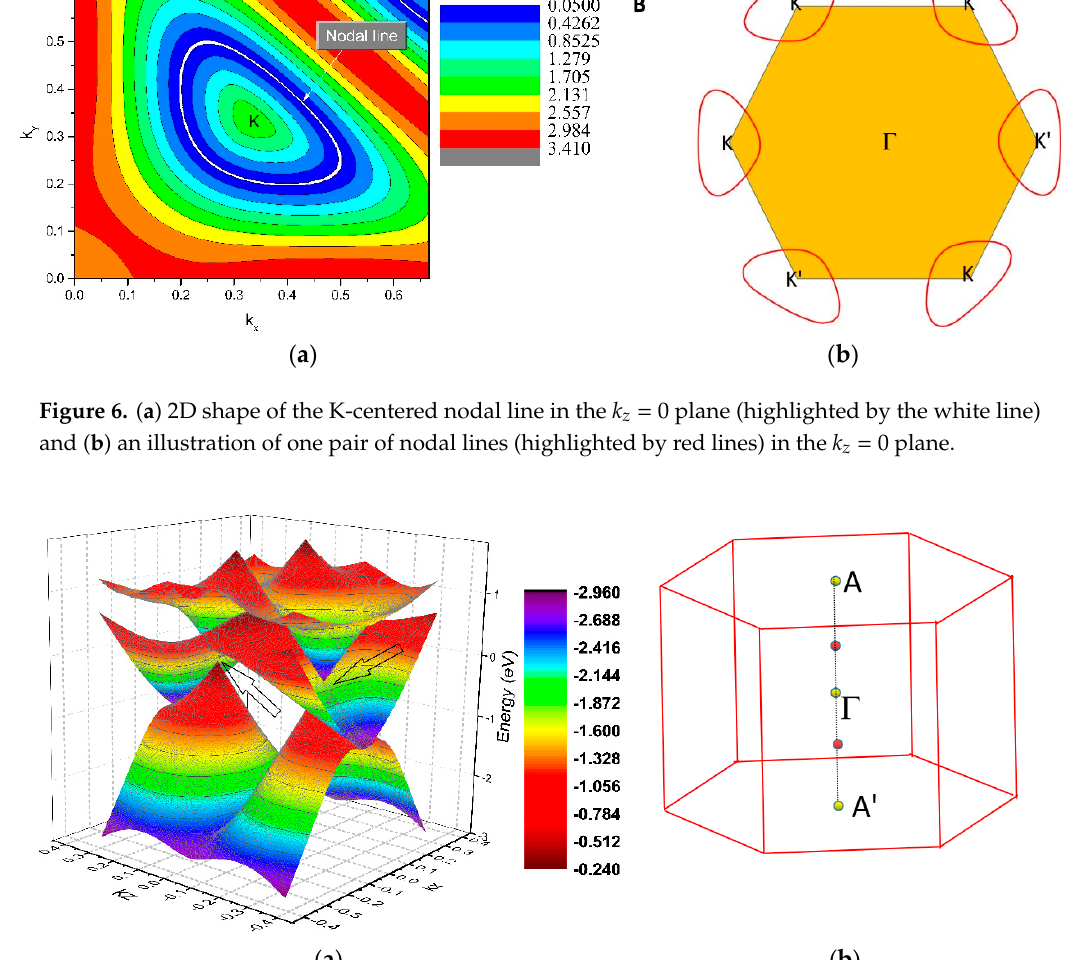
Figure 6. ( a ) 2D shape of the K-centered nodal line in the k z = 0 plane (highlighted by the white line) and ( b ) an illustration of one pair of nodal lines (highlighted by red lines) in the k z = 0 plane.